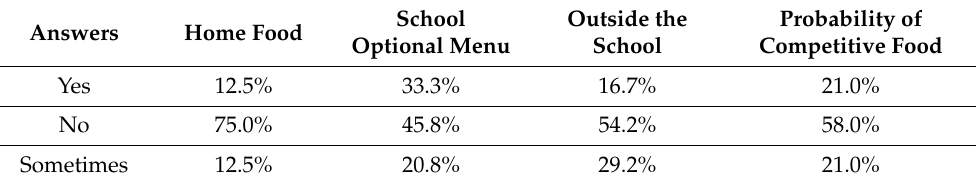
Table 4. Survey answers about the sources of competitive food.